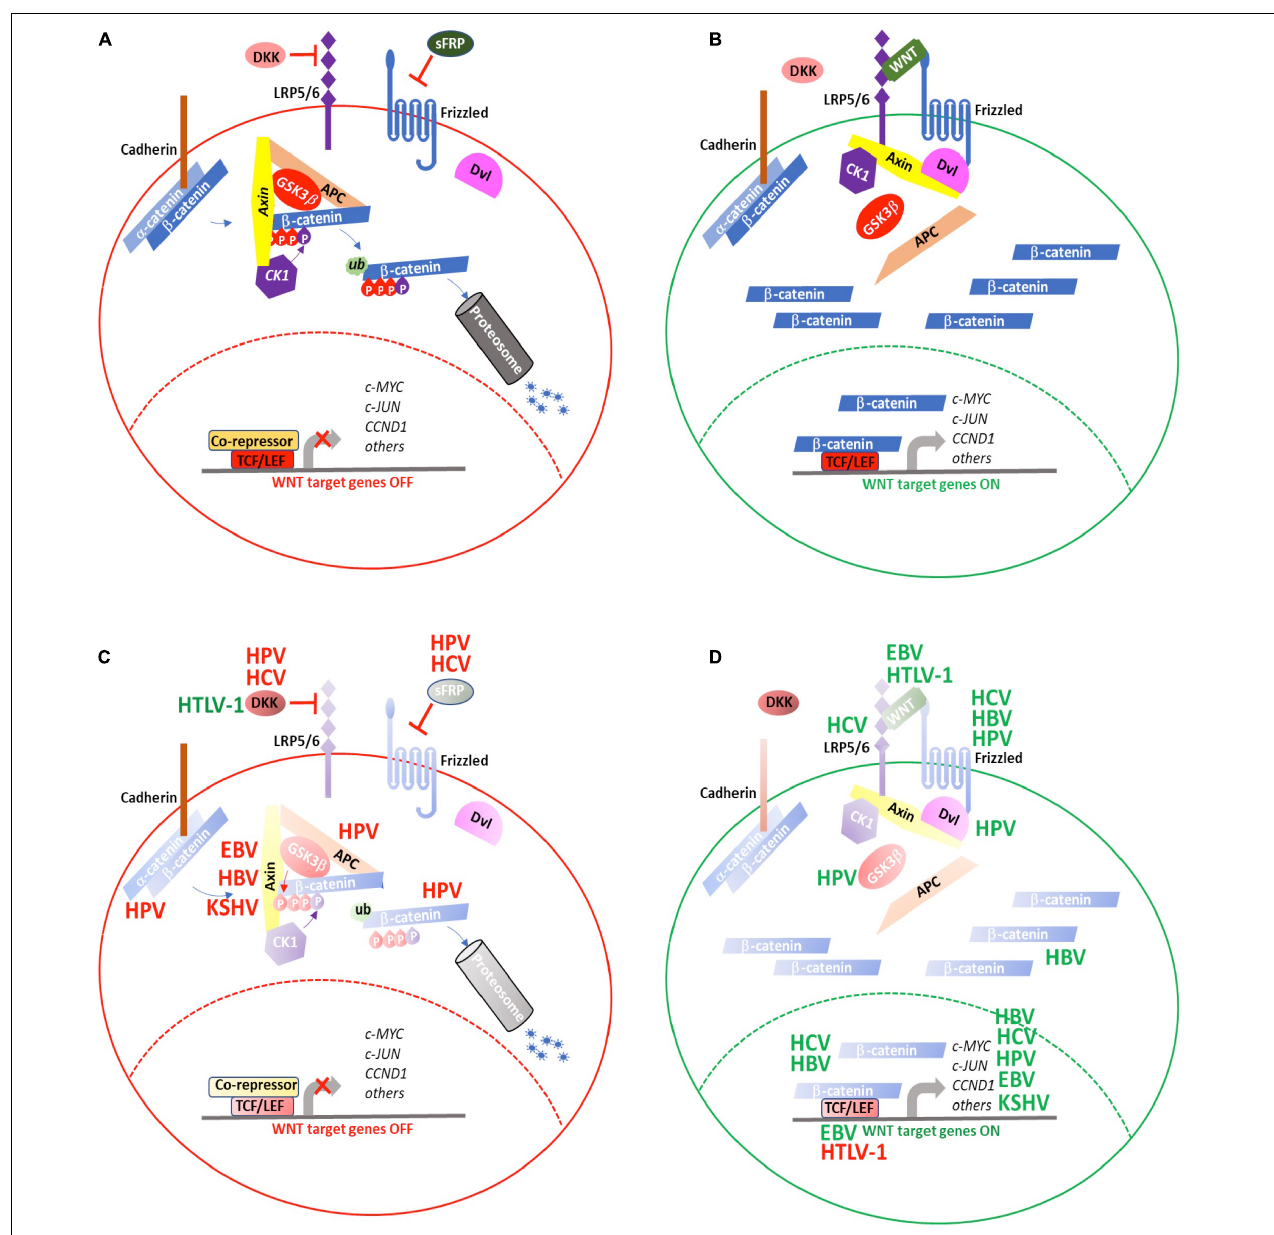
FIGURE 4 | WNT signaling is targeted by oncogenic viruses during tumorigenesis. (A) WNT signaling is maintained in an “OFF” state by active processes that result in proteosomal degradation of cytosolic β -catenin and prevent transcription of WNT target genes. (B) Secretion of WNT ligands activate signaling though FZD and LRP5/6 to recruit the AxinAXIN-APC-GSK3 α GSK3b complex away from β -catenin, resulting in its cytosolic stabilization and eventual translocation to the nucleus where it activates the TCF/LEF transcriptional complex to induce expression of WNT target genes. The oncogenic viruses, HBV, HCV, HPV, EBV, HTLV-1, and KSHV target various aspects of WNT signaling either to (C) repress inhibitors of or (D) enhance positive regulators of WNT signaling. (red) Negative regulation; (green) positive regulation. See text for